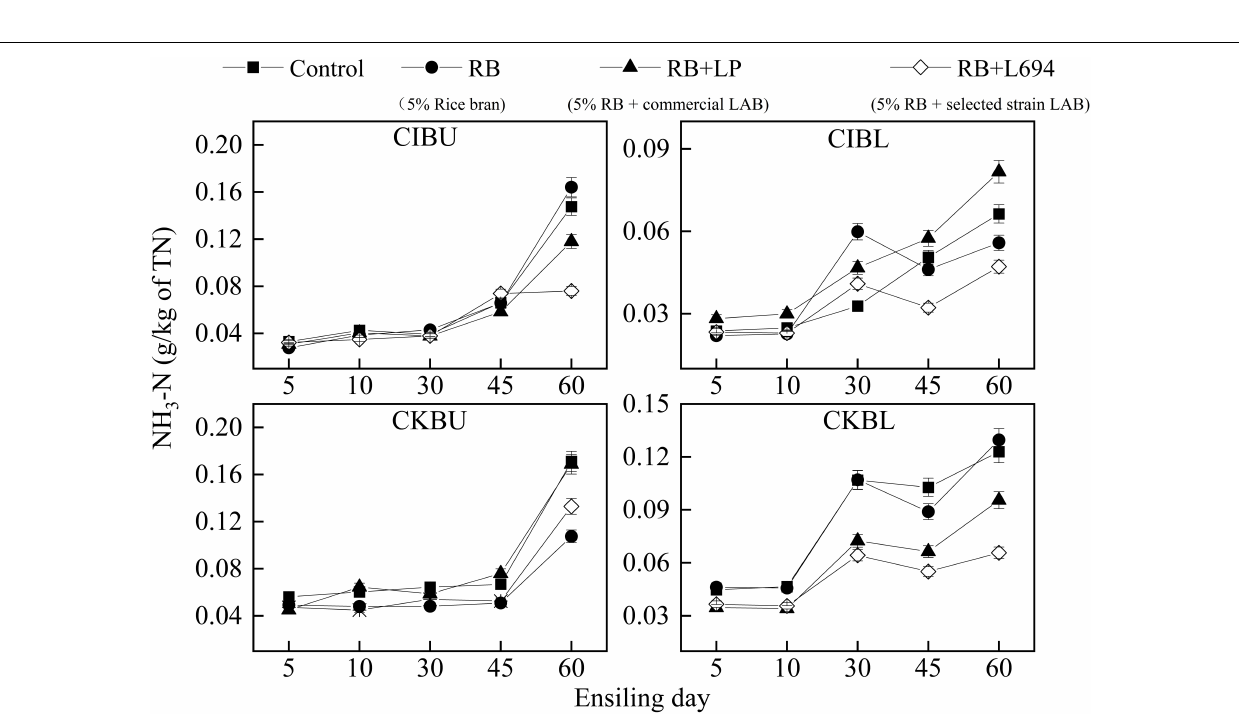
FIGURE 2 | NH 3 -N dynamics of Caragana intermedia (CI) and Caragana korshinskii (CK) silages at the budding (BU) and blooming stages (BL) during ensiling. RB, 5% rice bran; LP, commercial inoculant strain Lactobacillus plantarum ; L694, a selected strain Lactobacillus ( n = 3).